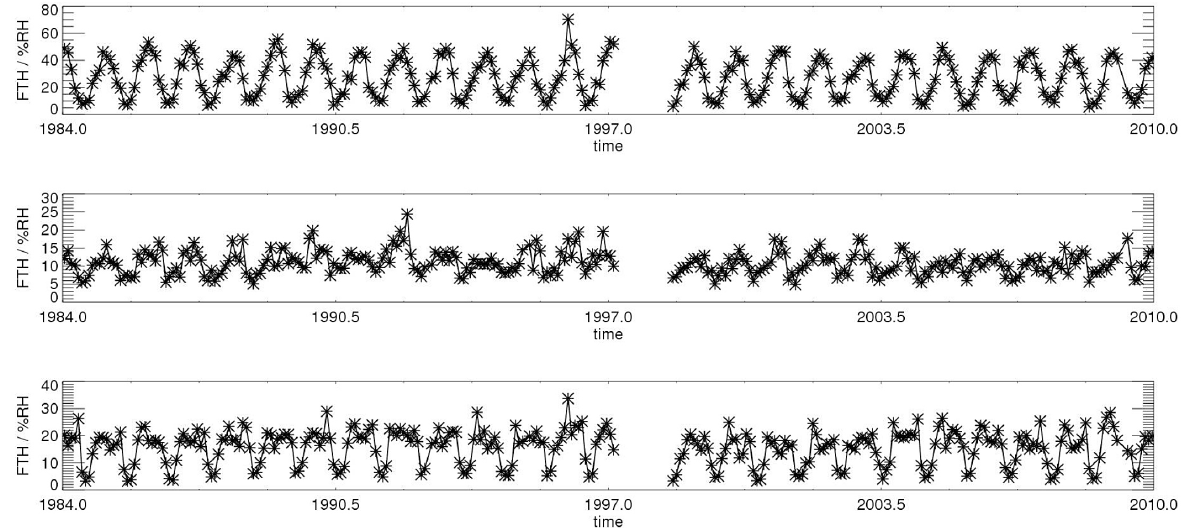
Figure 5. Time series of regional FTH averaged over south-central Africa (top), the South Atlantic (middle) and northeastern Africa (bottom). The regions are shown in the bottom left panel in Fig.